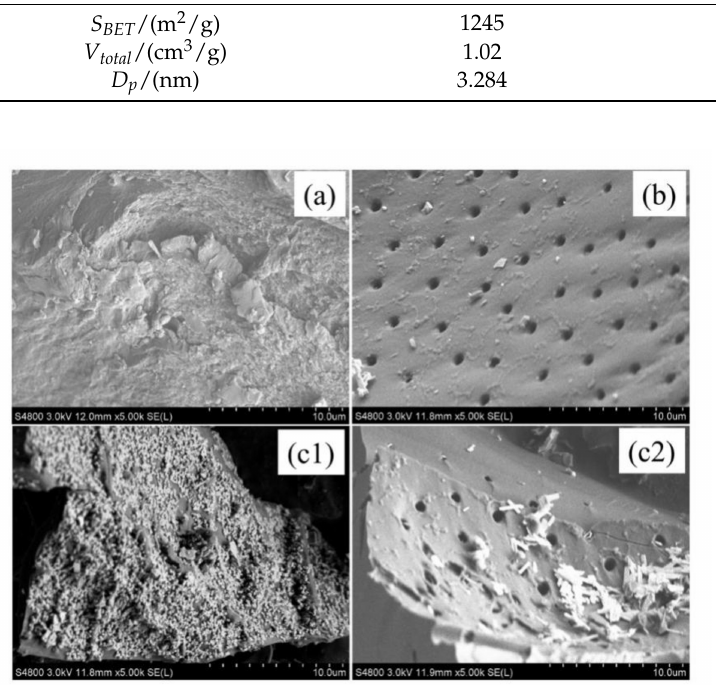
Figure 6. Pore size distribution of COS, COSC-0, and COSC-1. Table 2. Specific surface area and pore structures of COSC-0 and COSC-1. Samples